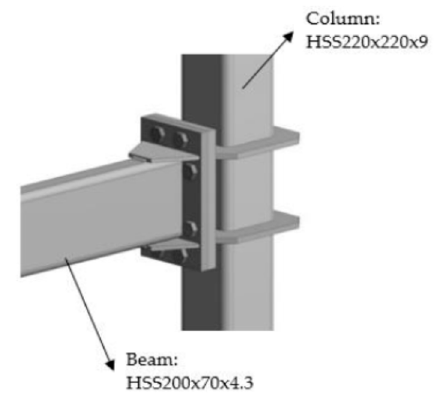
Figure 15. End-plate connections to square hollow structural section columns (EP-HSS) connection with HSS beam and HSS column showing a non-ductile behaviour [158] reproduced under the Creative Commons Attribution 4.0 International License, (http://creativecommons.org/licenses/by/4.0/).